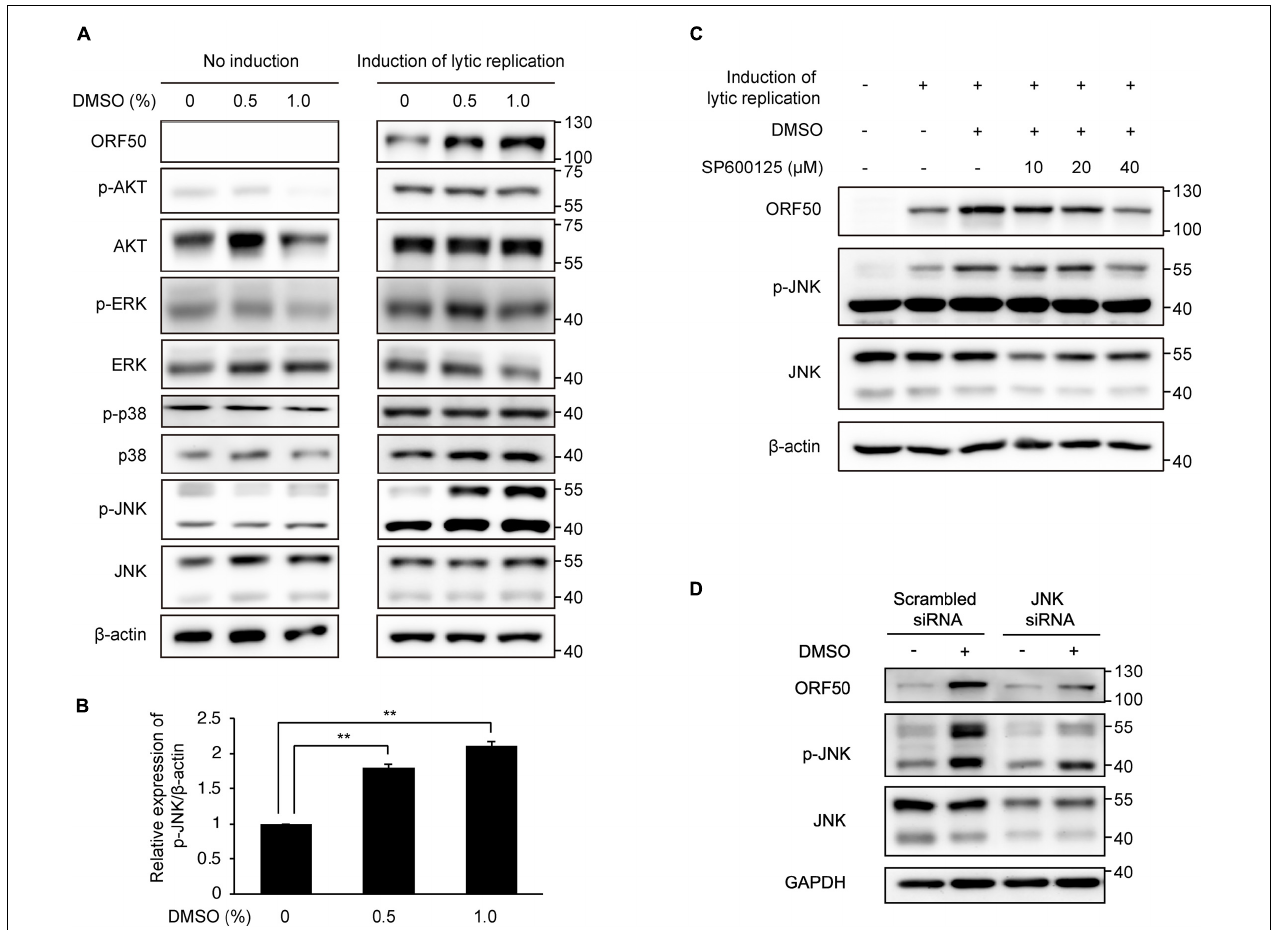
FIGURE 7 | Enhanced lytic replication by DMSO was mediated by increased phosphorylation of JNK. Cells were then treated with DMSO during lytic replication. No induction samples were treated with DMSO alone. Lytic replication was induced in iSLK BAC16 cells with doxycycline and sodium butyrate. (A) Western blot analysis of signaling molecules related to lytic replication of KSHV. (B) Densitometric analysis of phospho-JNK/ β -actin levels in iSLK BAC16 cells treated with DMSO and lytic replication-inducing agents. Data are shown as the mean ± SD, n = 3, and ** p < 0.01. (C,D) Effects of the JNK inhibitor SP600125 or siRNA-mediated suppression of JNK on KSHV lytic replication in DMSO-treated iSLK BAC16 cells. Cells were treated with 10, 20, or 40 µ M of SP600125 at the beginning of lytic activation with DMSO. After 24 h, cell lysates were collected, and the indicated proteins were analyzed by western blot analysis with specific antibodies (C) . For suppression of JNK with siRNA, iSLK BAC16 cells were transfected with JNK-specific small interfering RNA (JNK siRNA) and scrambled sequence control siRNA (scrambled siRNA) 24 h before lytic activation (D)